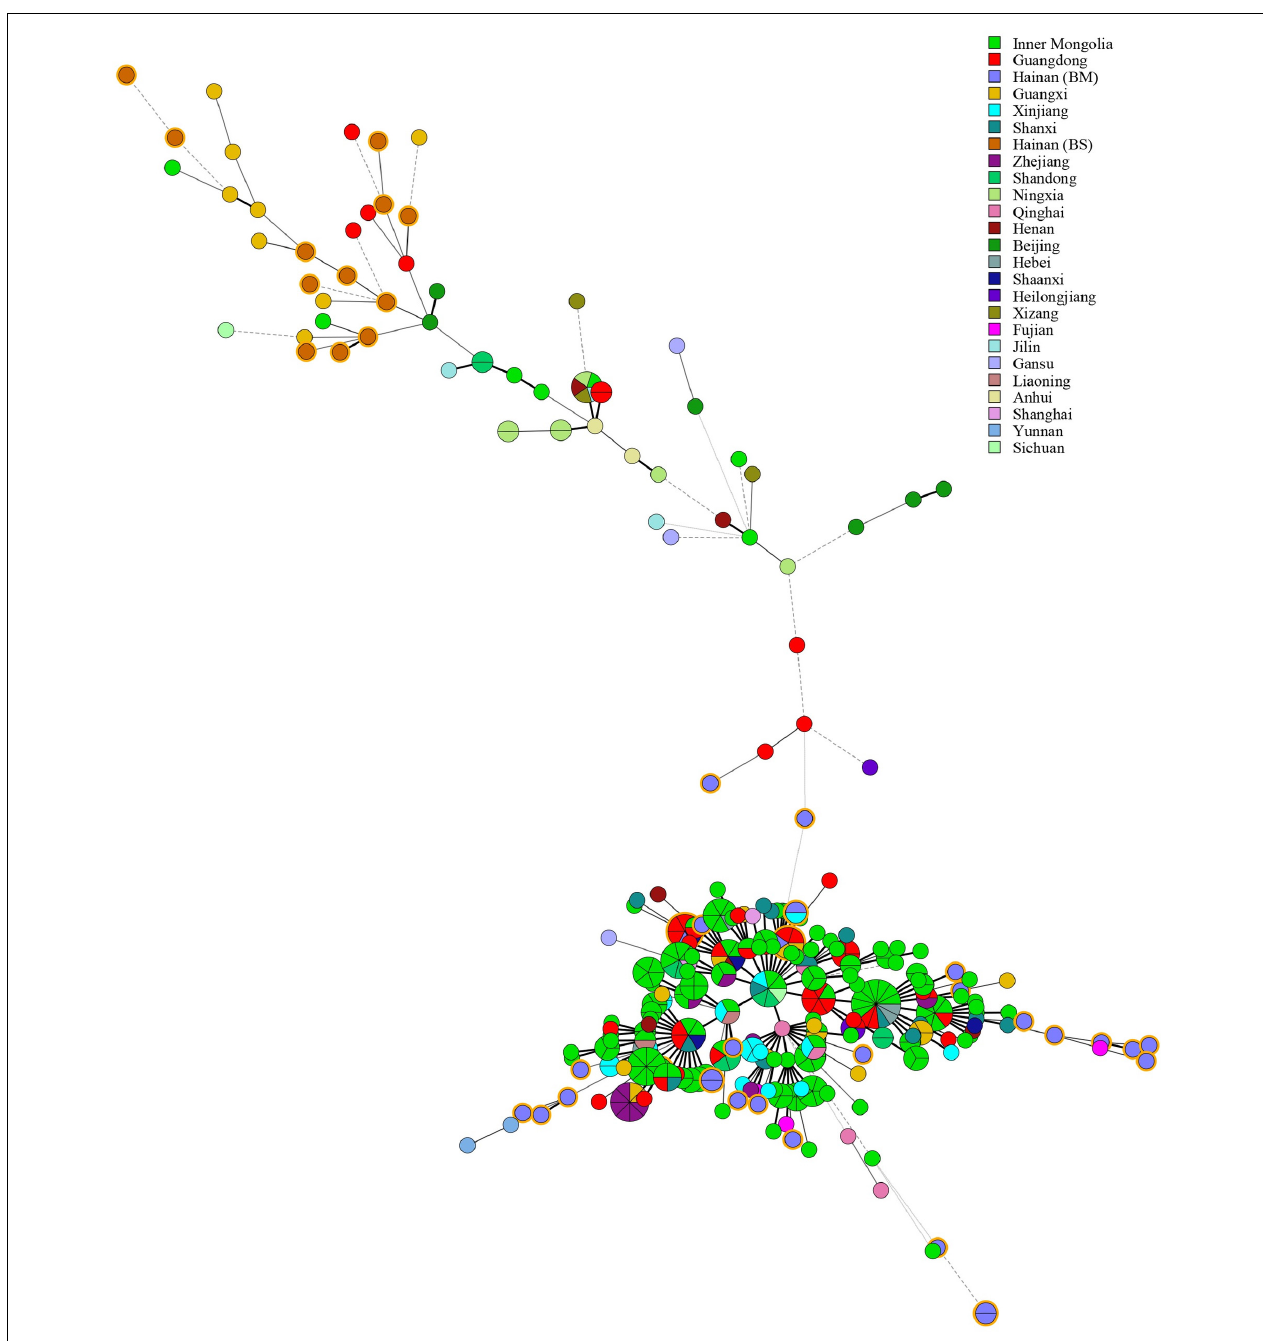
FIGURE 5 | Minimum Spanning Tree characteristics based on Brucella strains throughout China. The tree was constructed using MLVA-16 data from 367 profiles of Brucella available in the MLVA international database. The nodes including isolates from this study are highlighted in